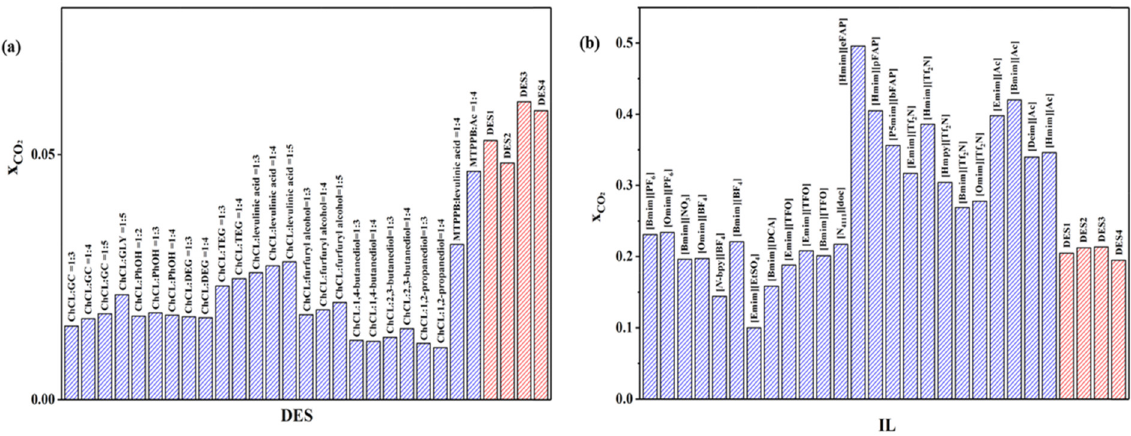
Figure 6. Comparison of CO 2 solubility in ( a ) DESs at around 500 kPa and ( b ) ILs at around 1500 kPa at 313.15 K. Ref. [139]. Copyright 2019, American Chemical Society.